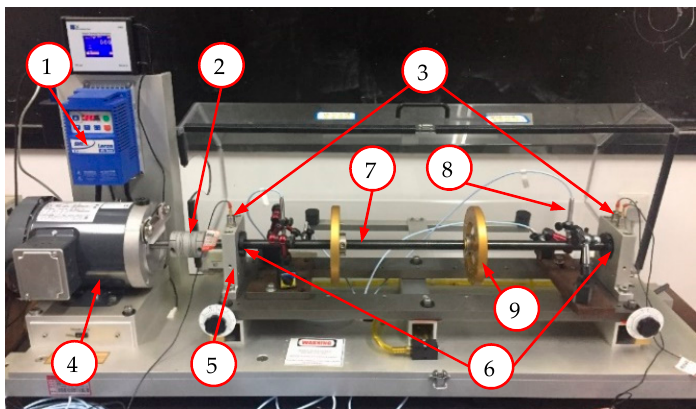
Figure 8. Machinery Fault Simulator-Rotor Dynamics Simulator (MFS-RDS) test bed. It can be used to simulate shaft, motor and bearing faults. The eddy current sensors are used to monitor the state of shaft. The data of them are not used for bearing diagnosis experiment. (1) speed controller, (2) rigid coupling, (3) accelerometer, (4) electromotor, (5) bearing base, (6) bearing, (7) shaft, (8) eddy current sensor, (9) rotary table .